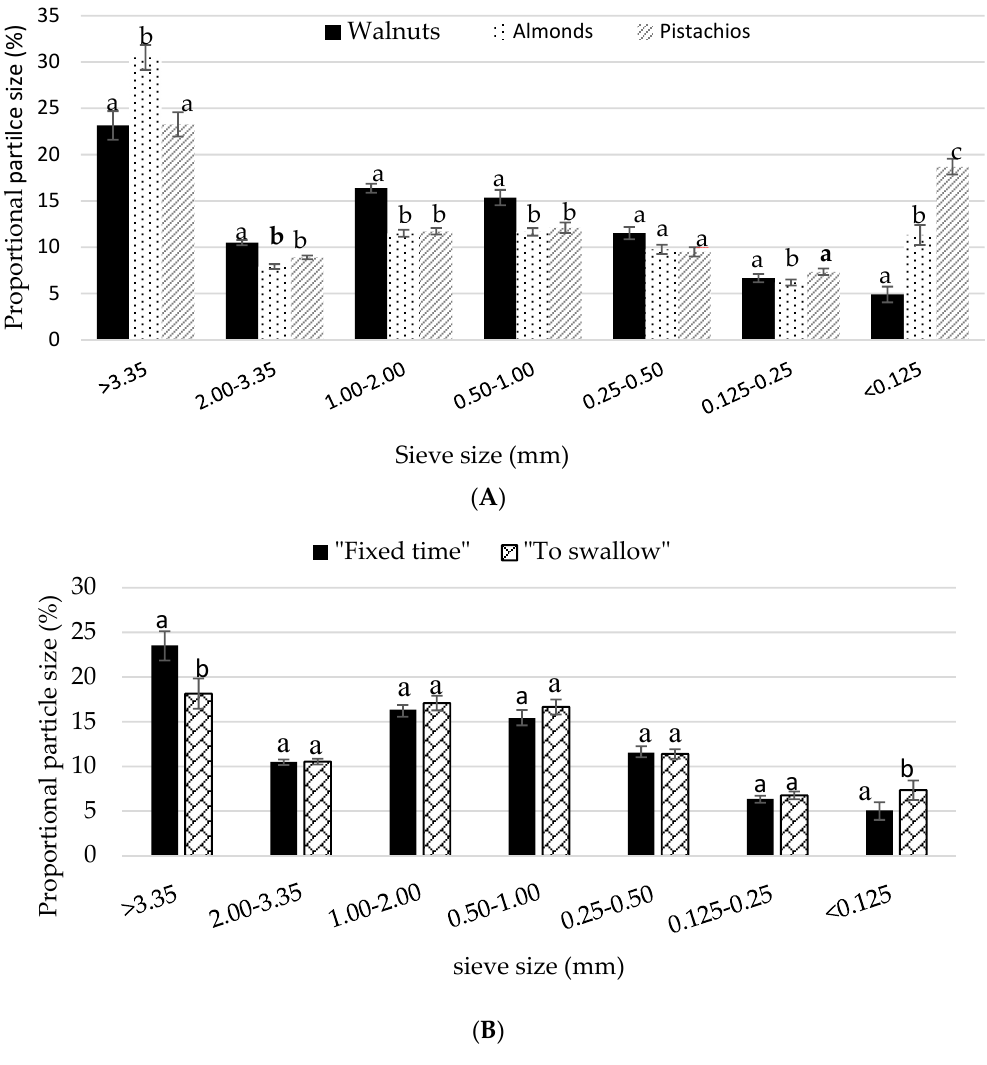
Figure 3. ( A ) Mean ± S.E.M particle size distribution of nuts chewed in isolation. Comparisons are based on two-way repeated measures ANOVA with post hoc Bonferroni multiple comparison test. Different lower case letters denote significant differences between nuts ( p < 0.05); ( B ) Mean ± S.E.M particle size distribution by size of walnuts chewed for a fixed time and to the point of swallowing. Letters that are different denote significant differences between mastication protocols ( p < 0.05).